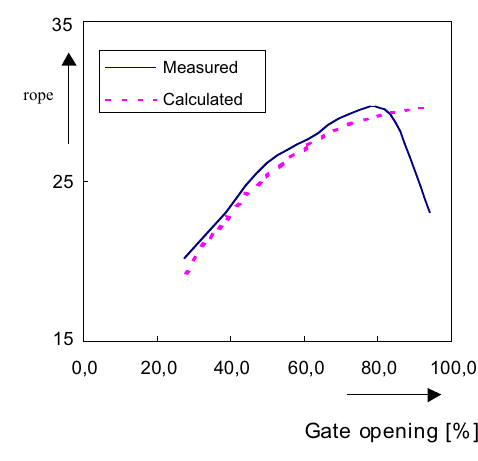
Fig. 10. Vortex rope